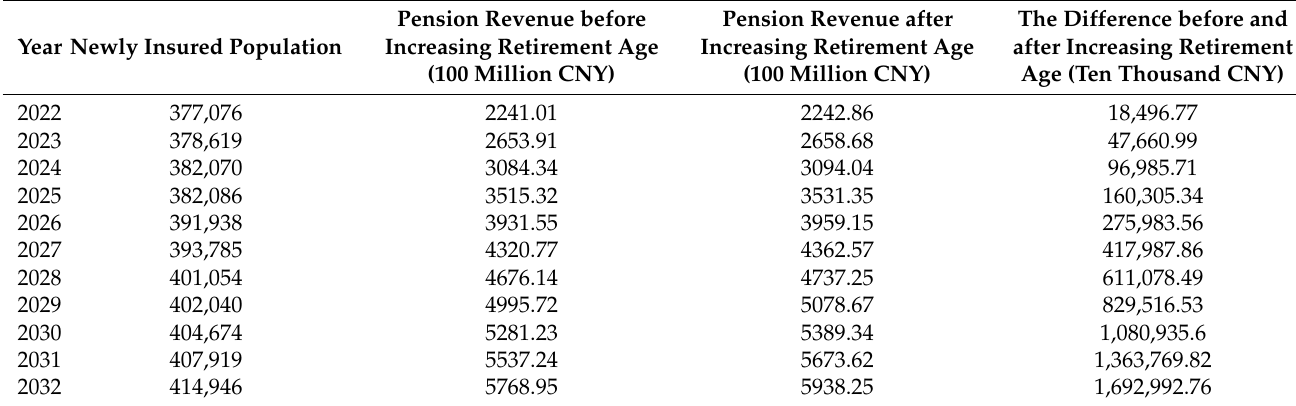
Table 9. Pension revenue of Anhui Province (deferred retirement plan I).